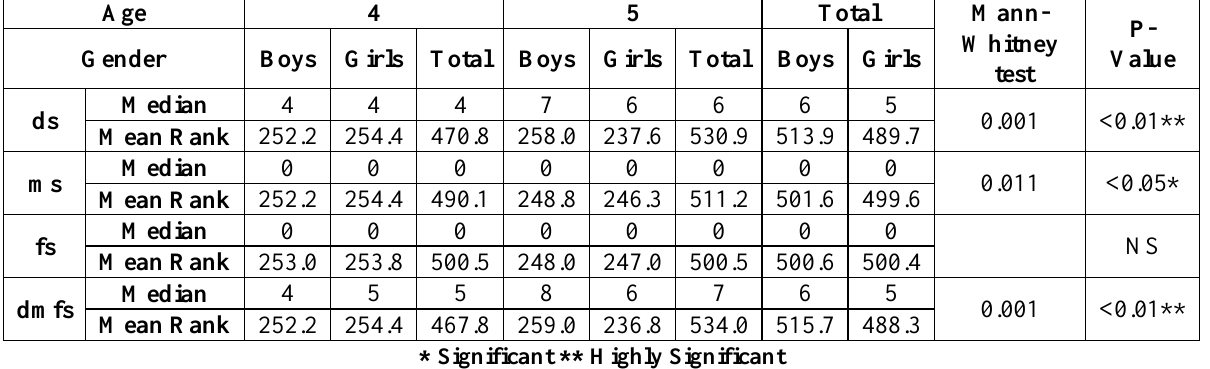
Table 2: Caries-experience (Median, Mean Rank of ds, ms, fs, dmfs) among children by age and gender.